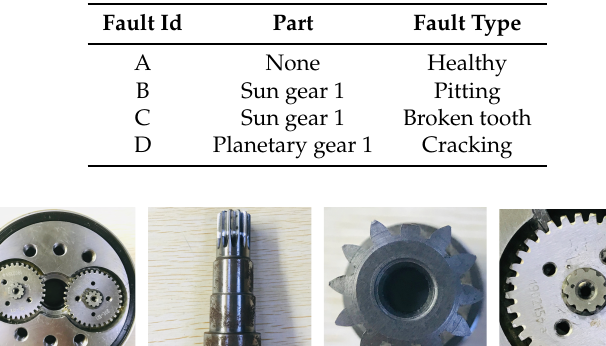
Figure 7. Monitoring the health state of the gears using vibrational signals acquired by an accelerometer located in the basis of the sixth axis of the manipulator. Table 1. Different fault patterns in the industrial manipulator.